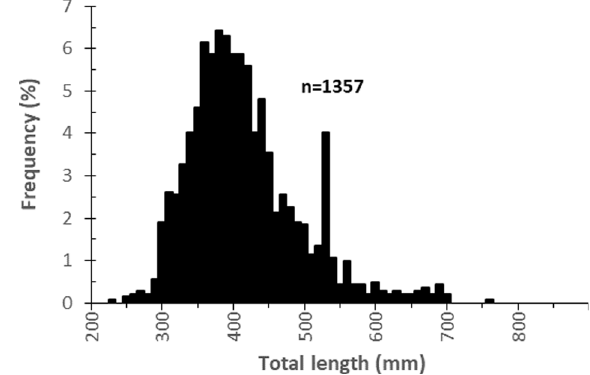
Fig. 2. Length-frequency distribution (10mm class interval) of yellow eels tagged during the study period from 2010 to